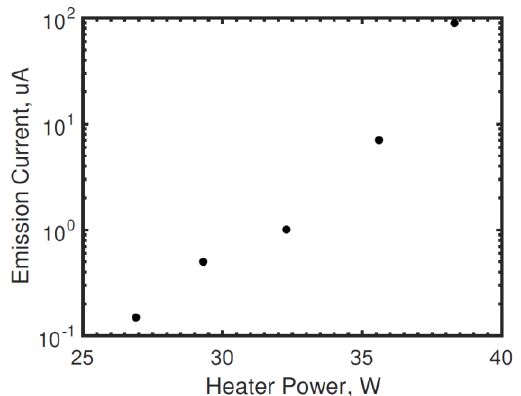
Figure 7. Emitted current as a function of heater power.